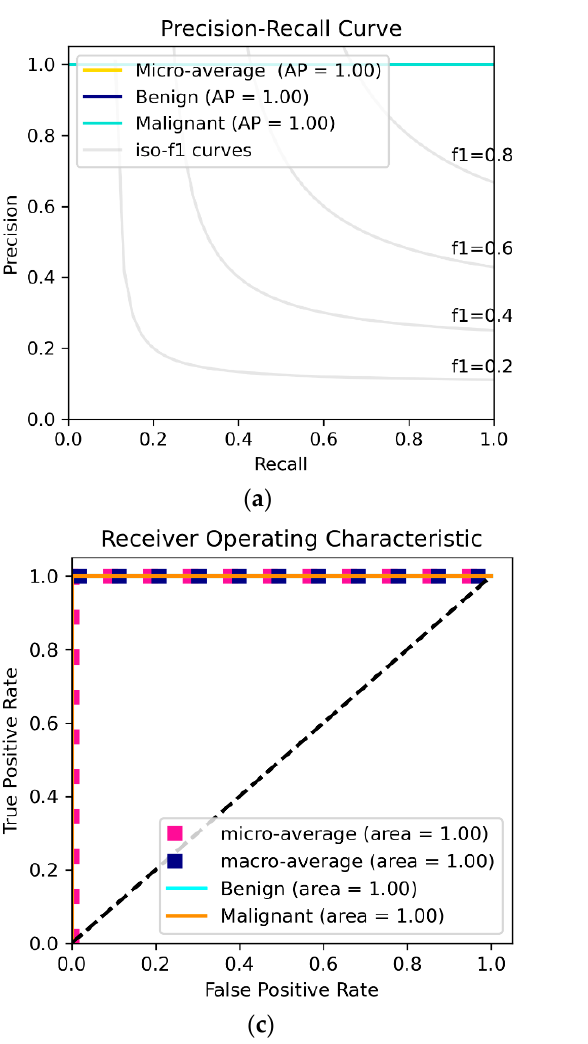
Figure 6. Binary Classification between Benign and Malignant. ( a ) depicts the PR Curve using the 100×, ( b ) depicts PR Curve @400× ( c ) depicts ROC curve @ 100×, and ( d ) depicts ROC curve @ 400× .